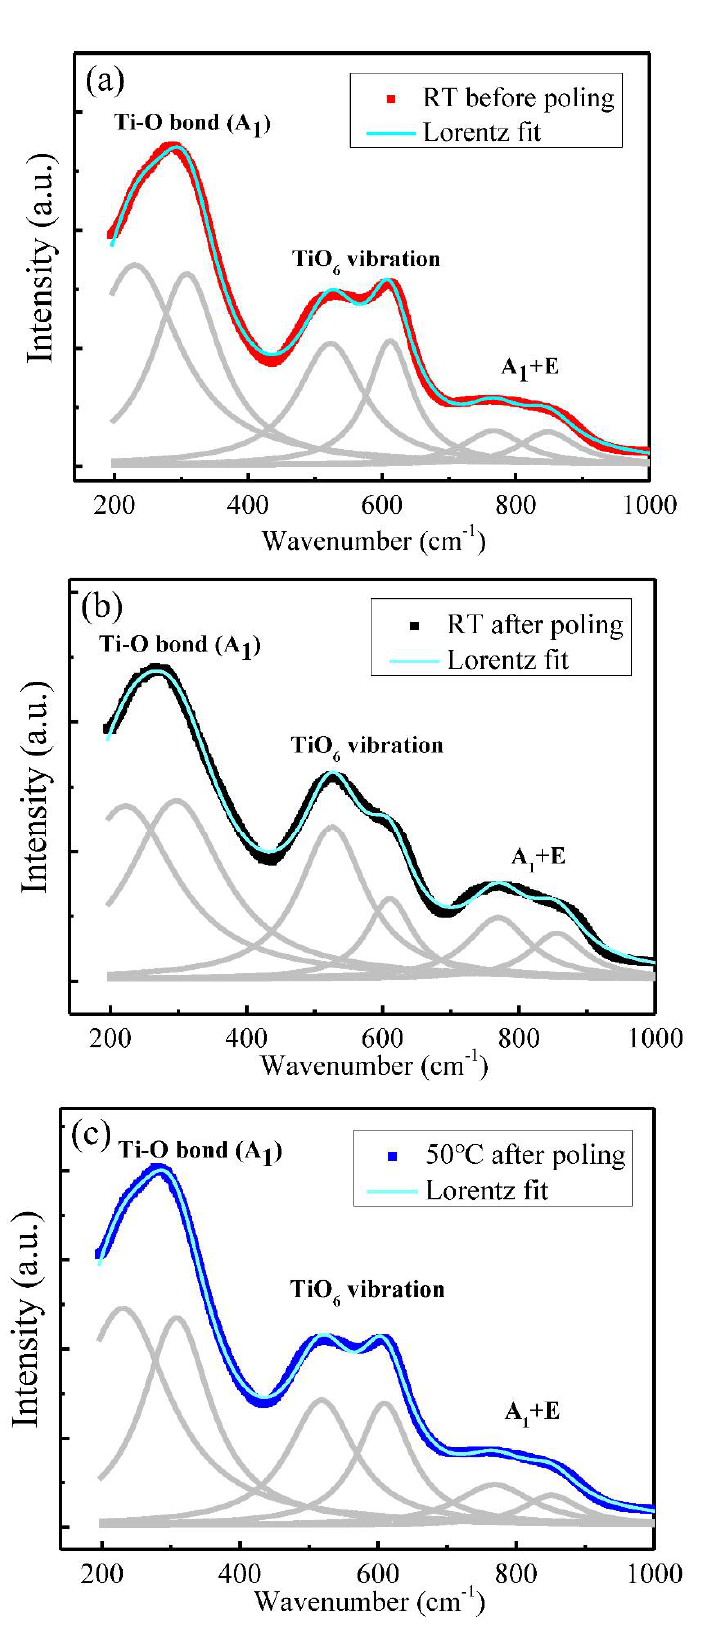
Figure 5. Raman spectra for <001>-oriented NBT-6BT-KNN crystal at different conditions: ( a ) room temperature (RT) before poling, ( b ) RT after poling, ( c ) 50 ℃ after poling.